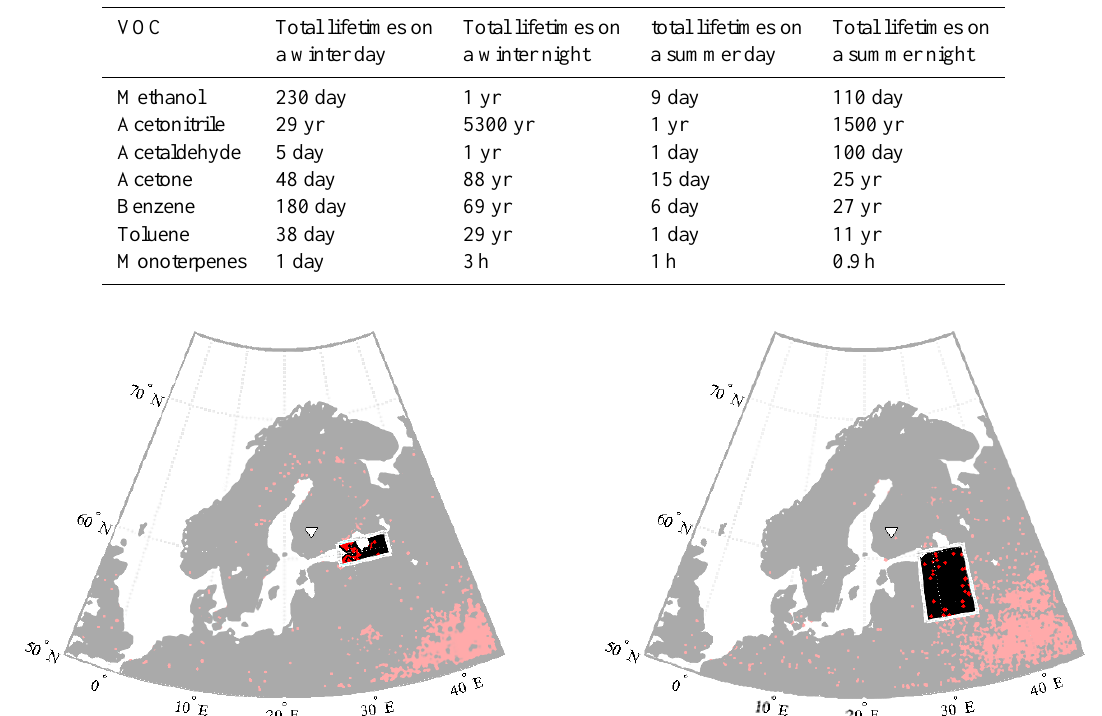
Figure 2. Map of forest fire locations during the forest fire episodes of the summers of 2006 (left) and 2010 (right). In 2006, the forest fire event occurred during 4–31 August and in 2010 during 20 July to 31 August. These maps depict the sum of all observed fire spots during the burning periods, each being shown by a dot. Data of forest fire locations are taken from the Fire Information Resource Managements System (FIRMS, 2014). The SMEAR II site is marked by a white triangle in the